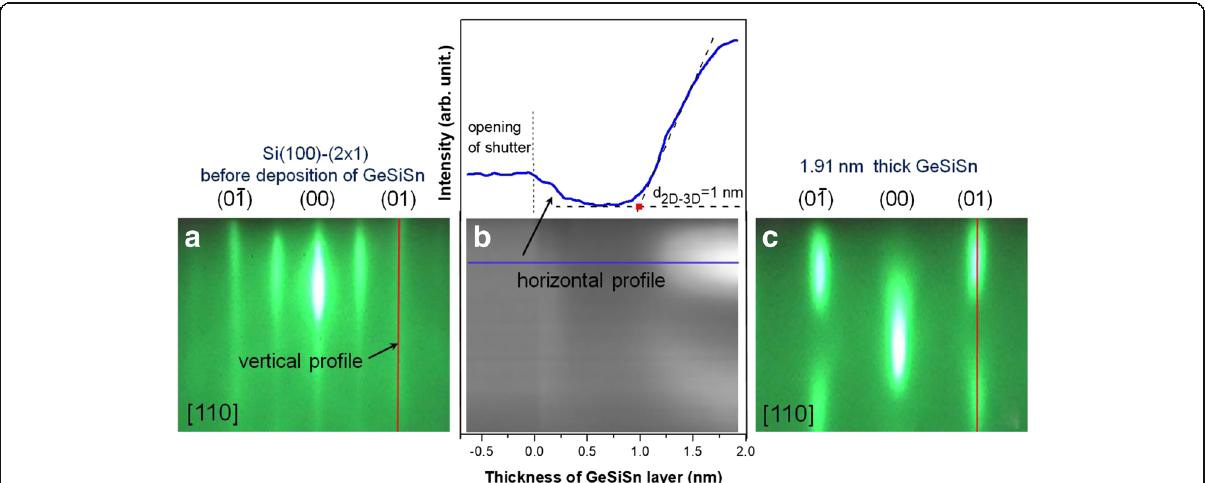
Fig. 1 2D-3D transition moment determination during the GeSiSn film growth: a RHEED pattern from the Si(100)-(2 × 1) surface before the Ge 0.6 Si 0.28 Sn 0.12 growth is shown, b the space-time intensity distribution of the vertical profile in the gray scale and the intensity dependence of the horizontal profile on the deposited Ge 0.6 Si 0.28 Sn 0.12 film thickness. The profiles are indicated by the arrows in ( a ) and ( b ), and c the final RHEED pattern after the 1.91-nm-thick Ge 0.6 Si 0.28 Sn 0.12 deposition